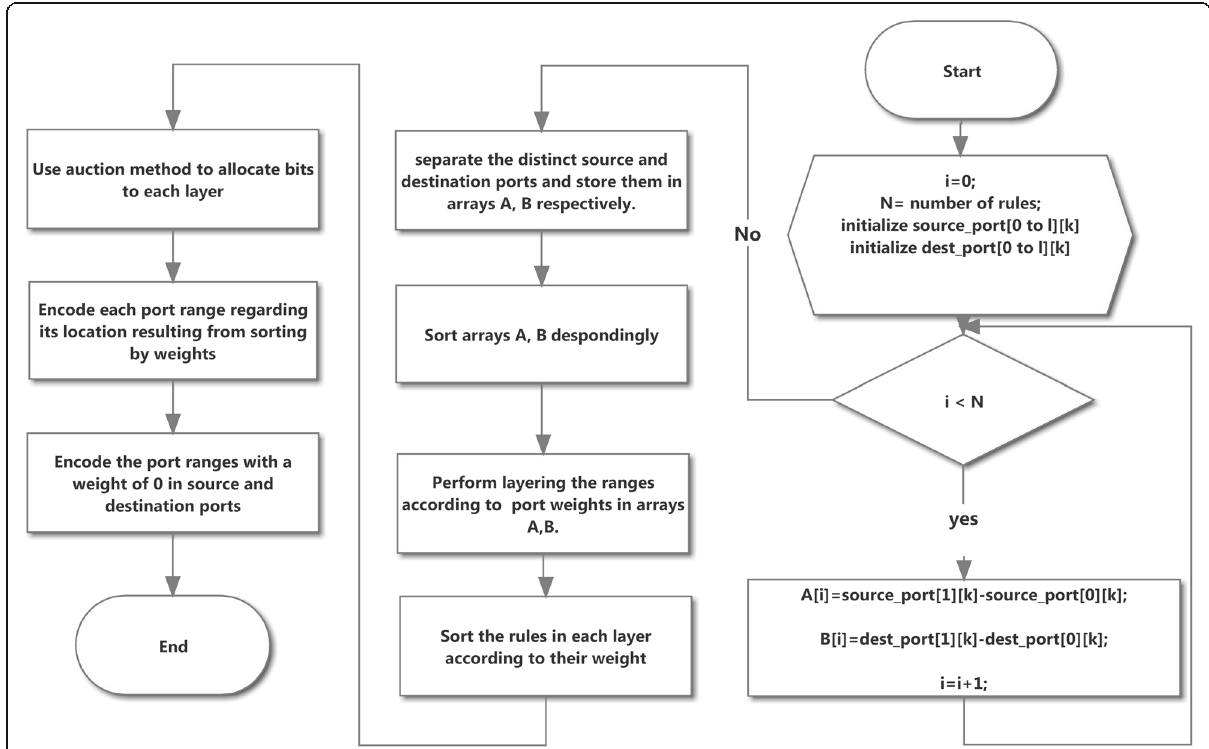
Fig. 5 Flowchart of the algorithm for encoding source and destination ports